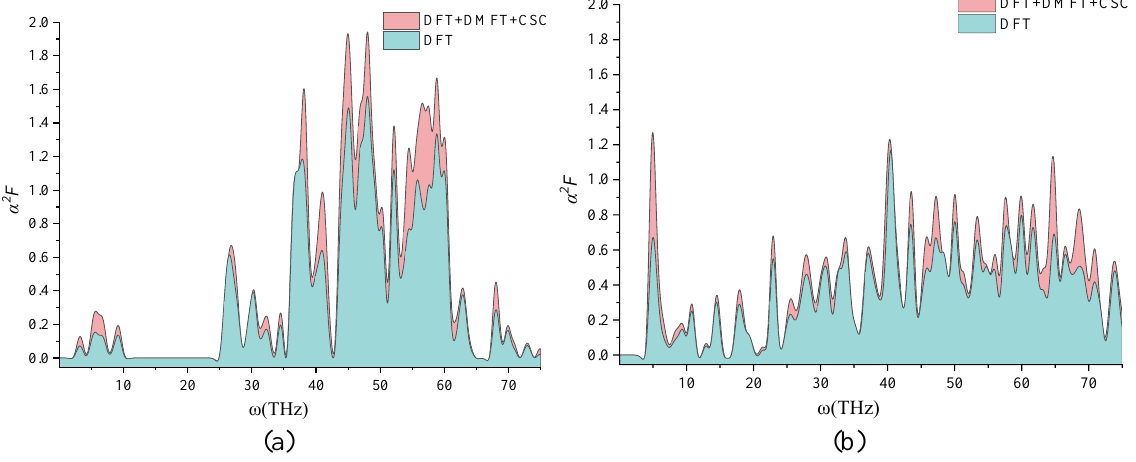
Figure 1. Eliashberg function α 2 F ( ω ) for ( a ) LaH 10 and ( b ) LaH 18 ; the spectral weight at the Fermi level is calculated with different extents of approximation: (i) DFT and (ii) with the full-charge self-consistent formalism (DFT + DMFT +